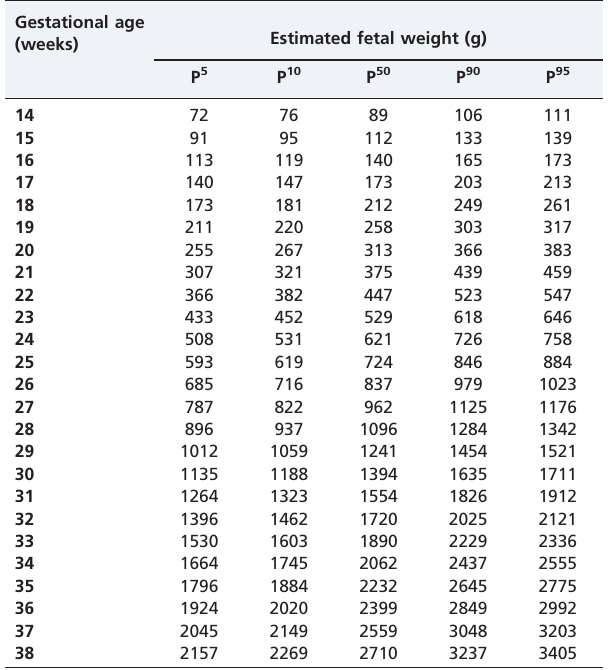
Table 6 - Longitudinal reference ranges for estimated fetal weight based on 807 ultrasound examinations performed on 250 fetuses from 125 uncomplicated, twin